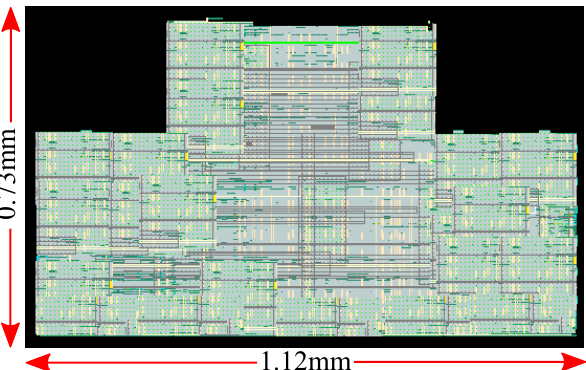
Figure 15. Layout of the proposed hardware-friendly SVM algorithm based on the design methodol- ogy (extra dummy transistors are